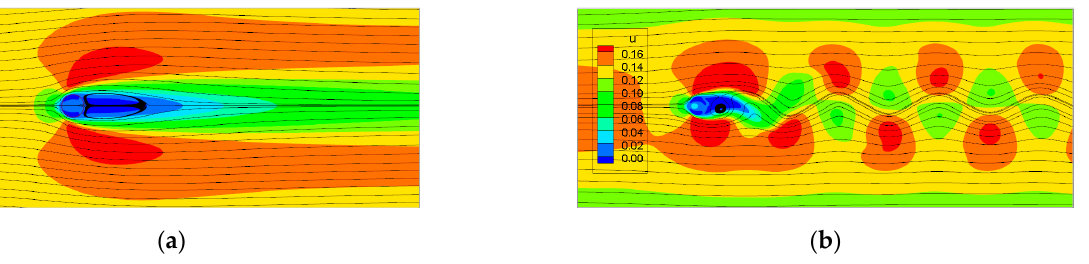
Figure 8. The relation between the damping coefficients of surge motion and the disturbance velocity in sway direction.